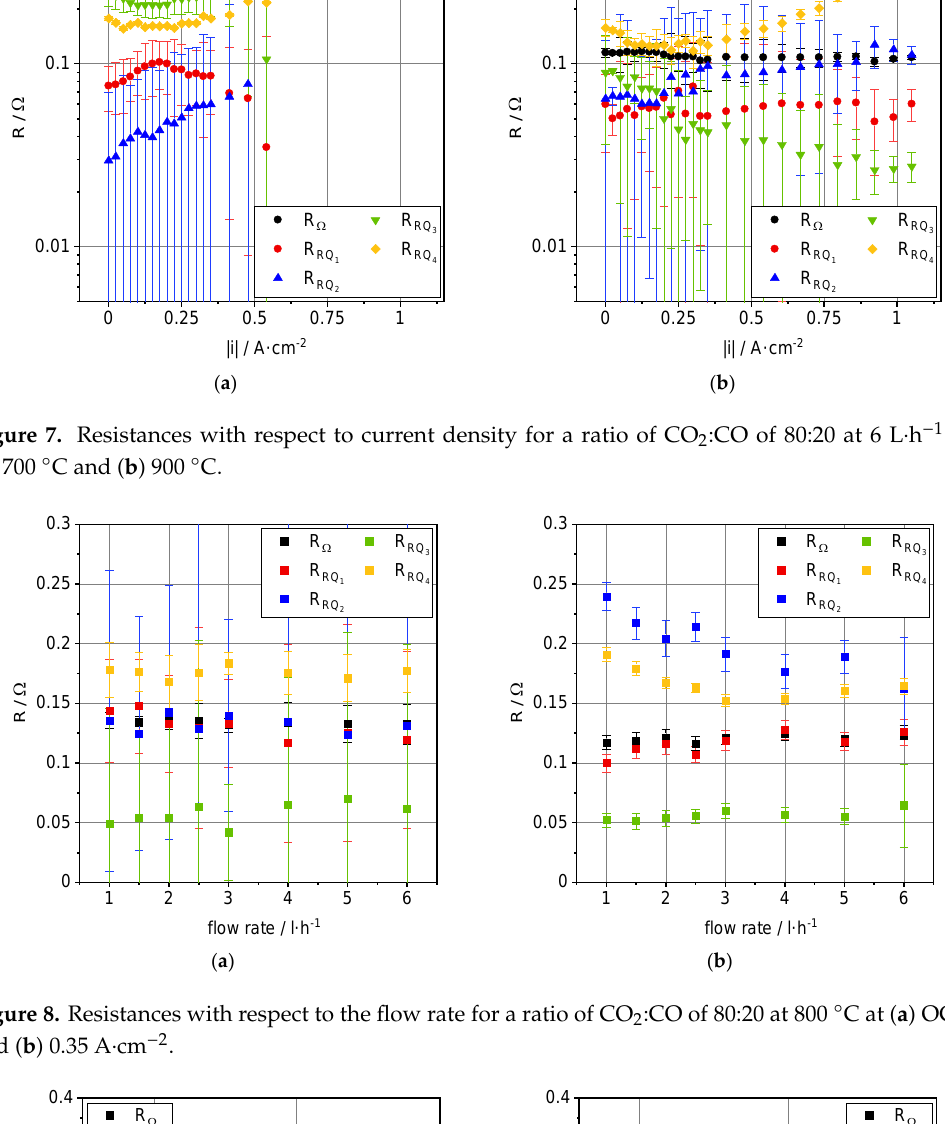
Figure 7. Resistances with respect to current density for a ratio of CO 2 :CO of 80:20 at 6 l·h -1 at ( a ) 700 °C and ( b ) 900 °C.